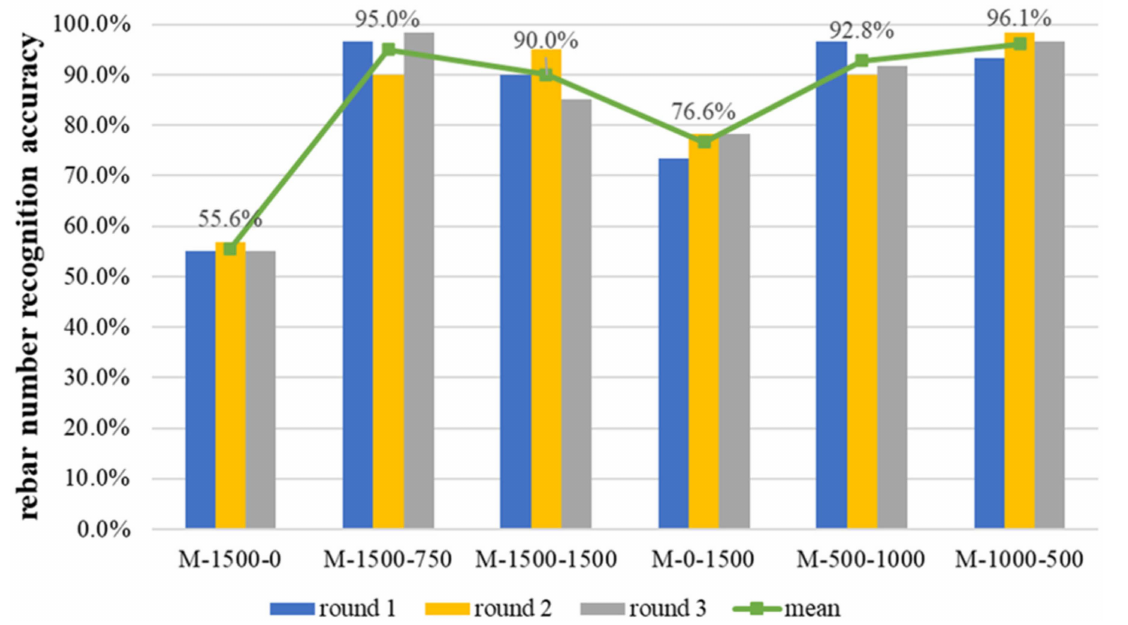
Figure 19. The results of three repeated experiments (rebar number recognition